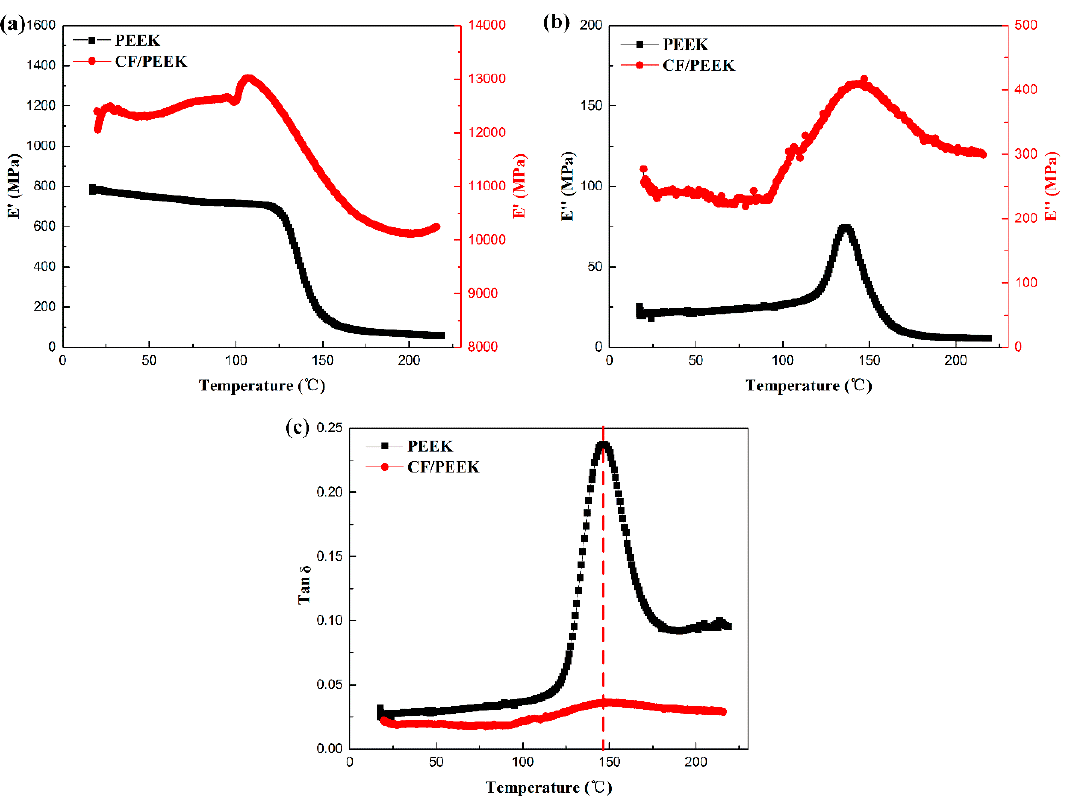
Figure 5. DMA results of PEEK and woven CF/PEEK composites: ( a ) the storage modulus (E ′ ) versus temperature; ( b ) the loss modulus (E ″ ) versus temperature, and ( c ) the tan δ versus temperature.